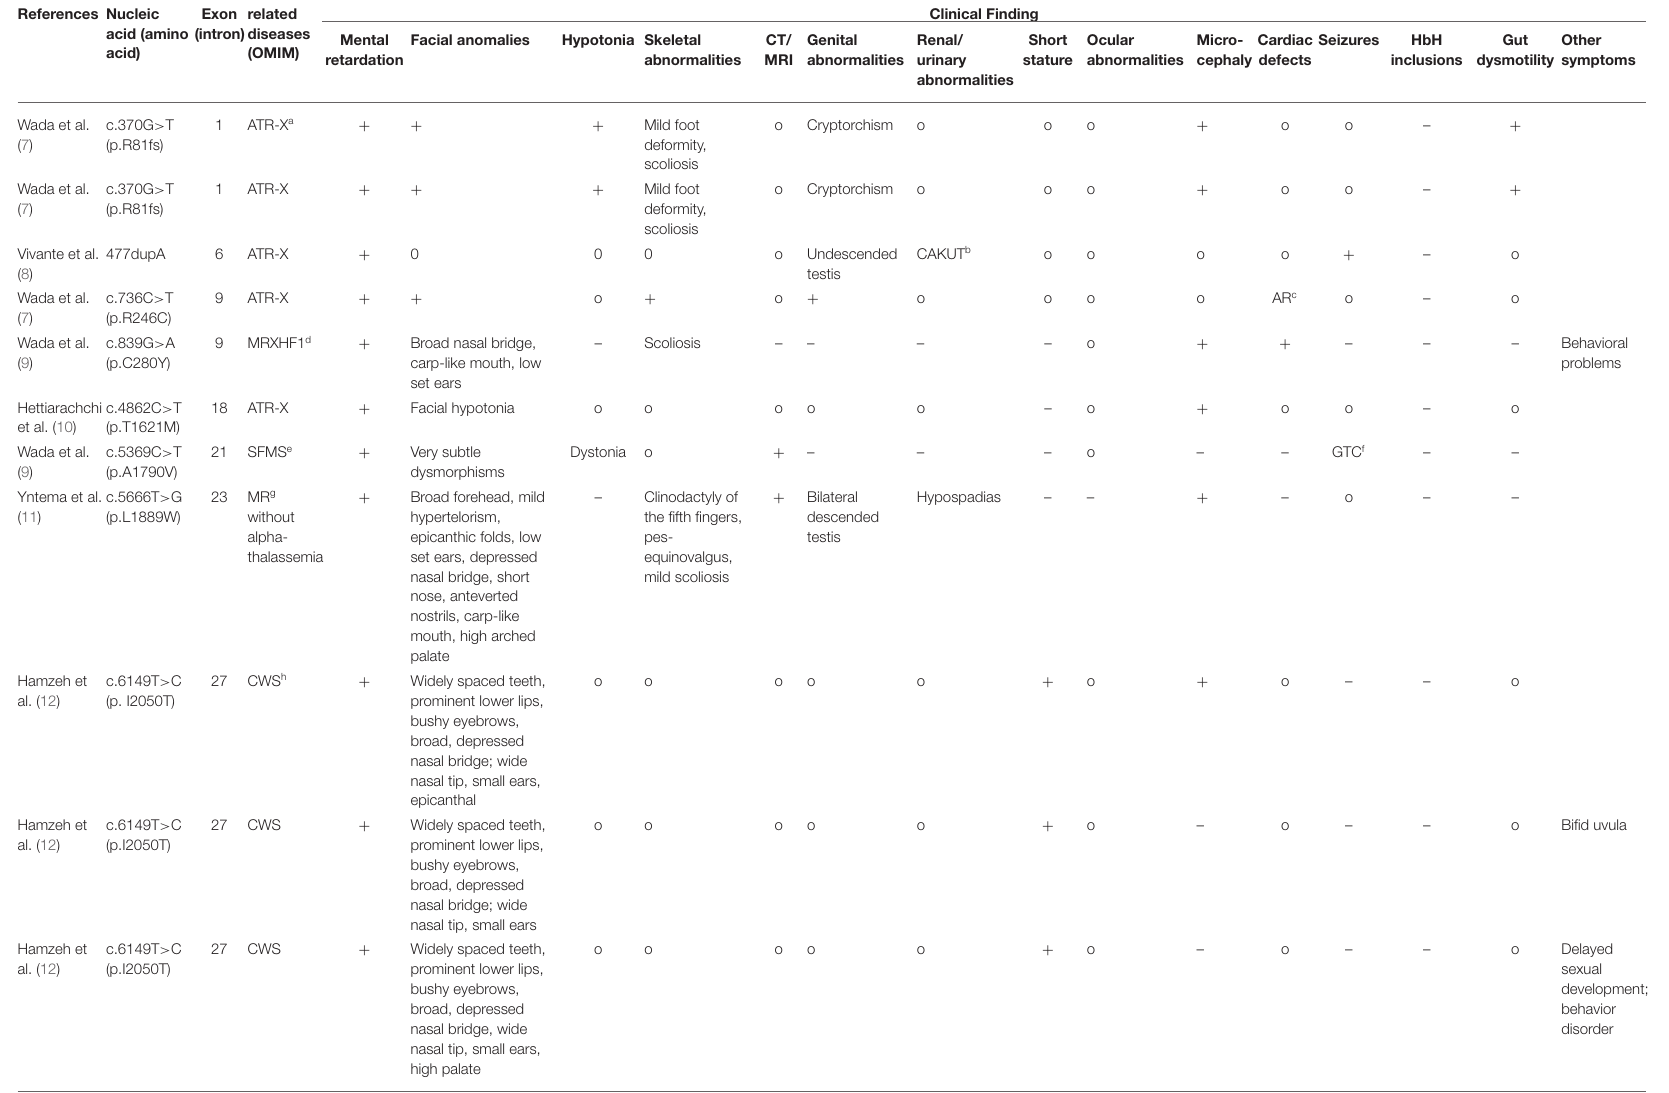
TABLE 1 | Previously reported cases carrying ATRX variants without